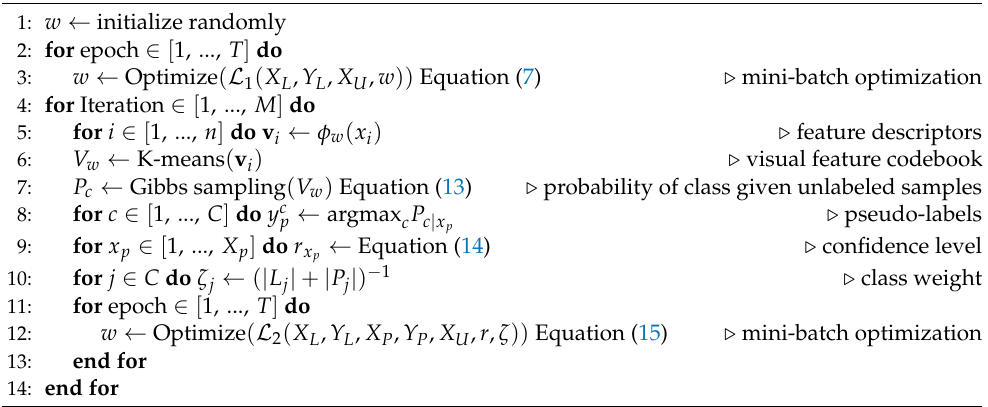
Algorithm 3 GeneratePseudo-labels iteratively via spatial